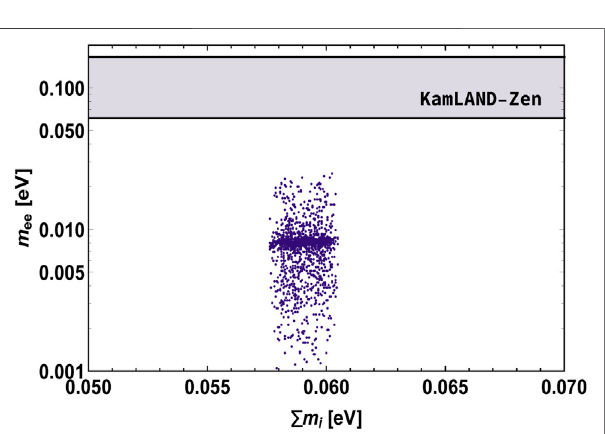
FIGURE 2 | Correlation plot between the effective neutrino mass m ee of neutrinoless double beta decay and the sum of active neutrino masses.